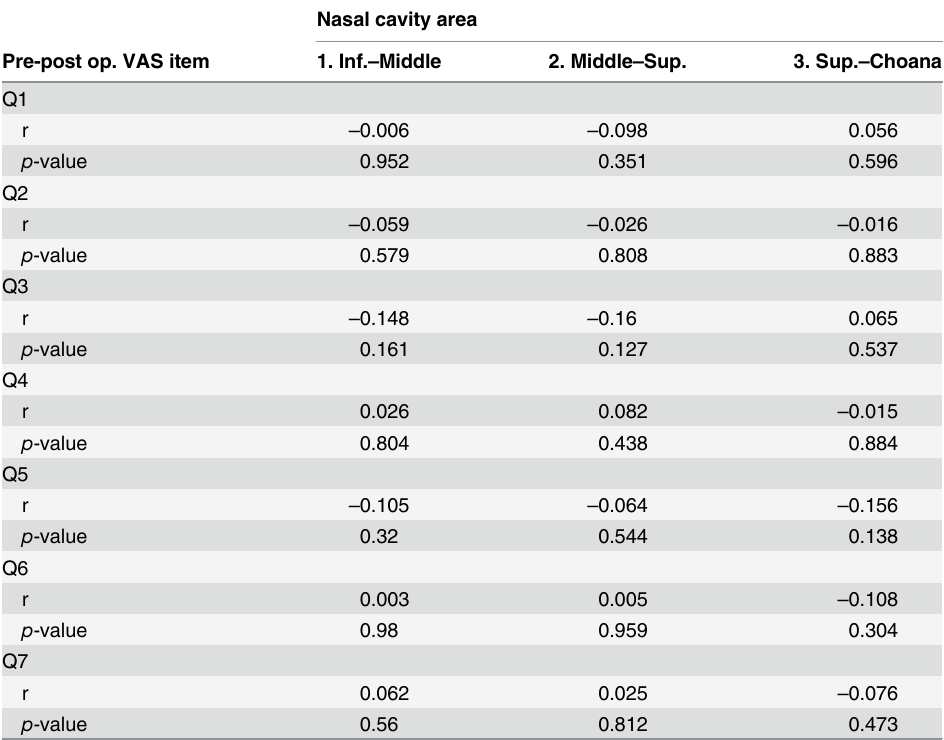
Table 5. Correlation between VAS score and nasal cavity